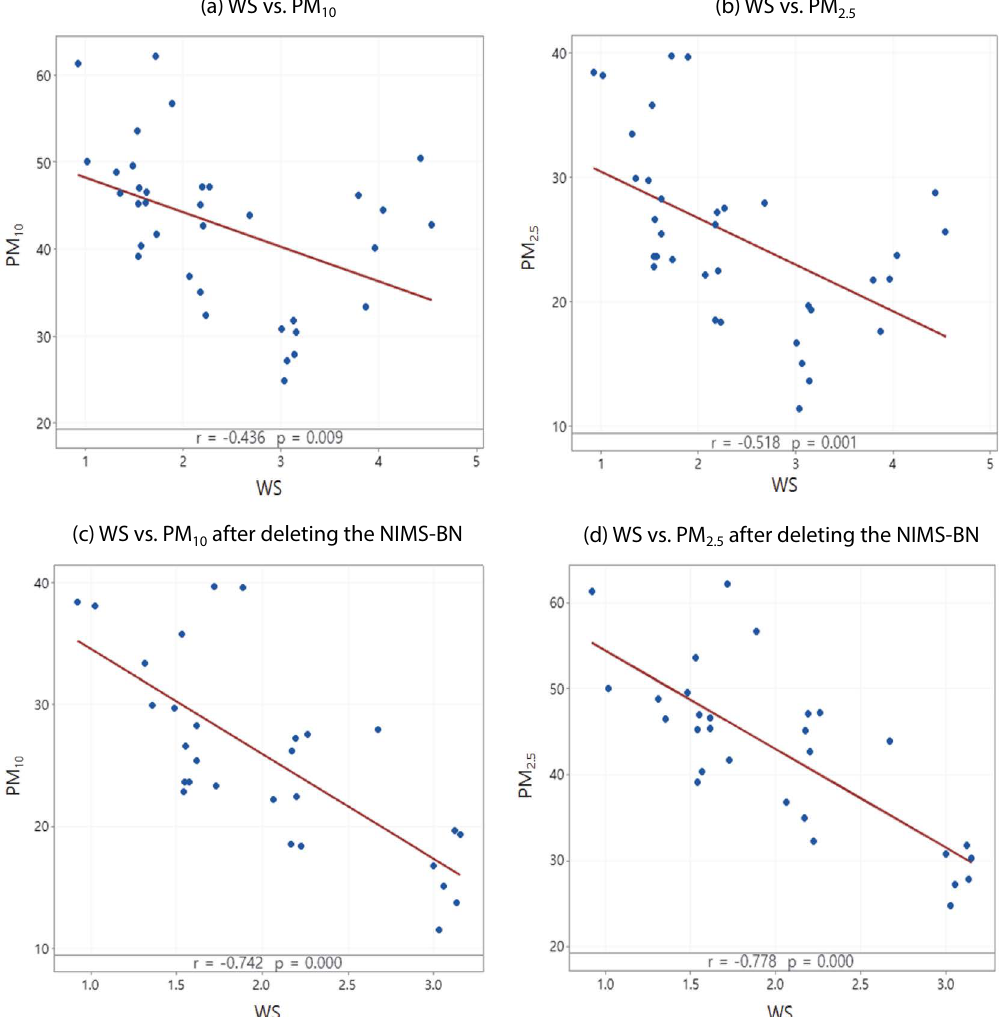
Fig. 2. Scattered correlation plots for WS vs. PM 10 and WS vs. PM 2.5 : (a) WS vs. PM 10 , (b) WS vs. PM 2.5 , (c) WS vs. PM 10 after deleting samples of NIMS-BN, and (d) WS vs. PM 2.5 after deleting samples of